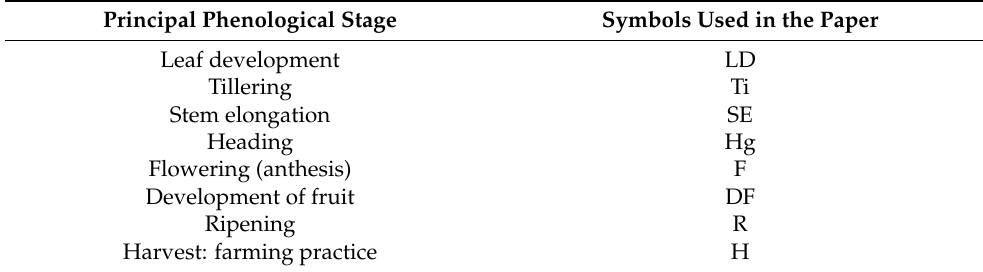
Table 1. Main phenological stages of the